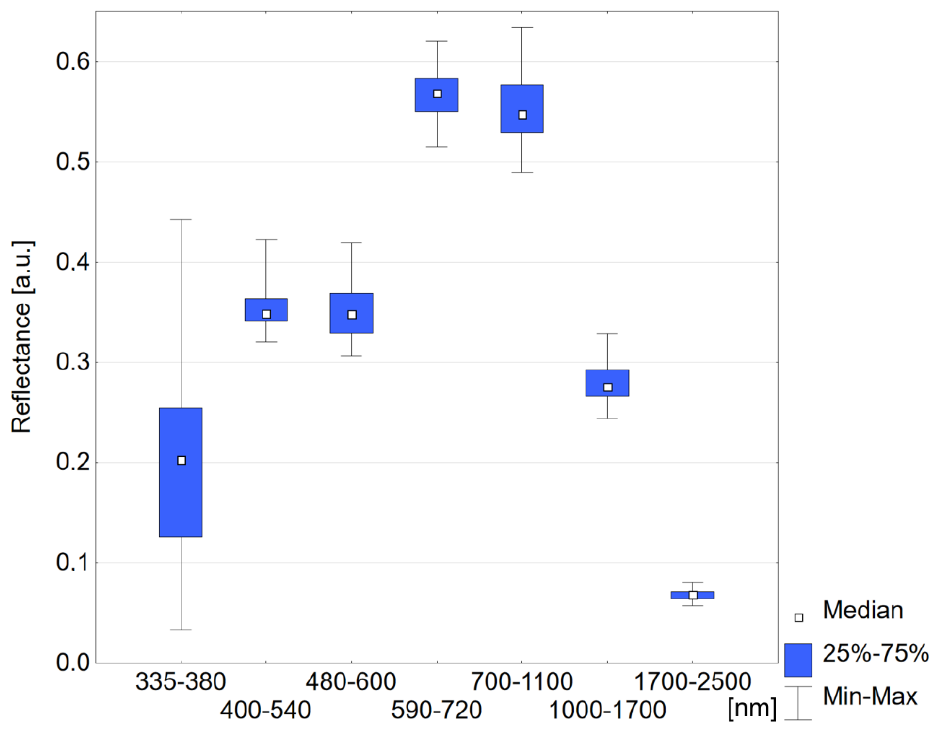
Figure 1. Histogram of the amount of skin sebum.